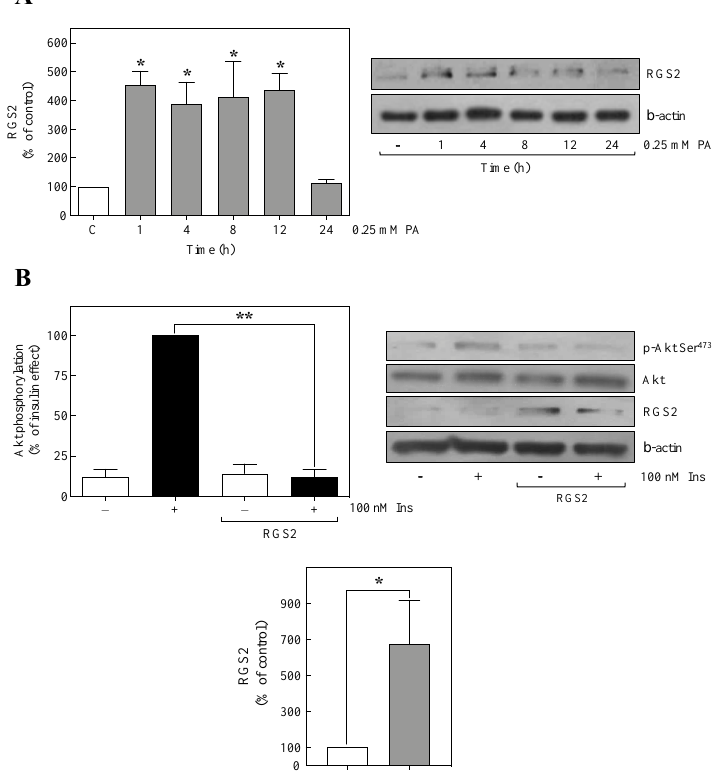
Figure 1. Increase in regulator of G-protein signaling 2 (RGS2) expression and insulin resistance. ( A ) Human umbilical vascular endothelial-CS (HUVEC-CS) cells were preincubated in the control medium (with dimethyl sulfoxide (DMSO)) for 24 h or medium containing 0.25 mM palmitic acid (PA) at different times before being harvested. Total cell lysates were separated by SDS-PAGE and analyzed by immunoblotting with anti-RGS2. Quantification of 3–6 independent experiments is expressed as mean ± S.E.M. The lower panel shows representative immunoblots. Western blots were also probed for total anti- β -actin as a loading control. ( B ) In the absence of PA, HUVEC-CS cells transiently transfected with human RGS2 were stimulated with 100 nM insulin for 10 min before being harvested. Total cell lysates were separated by SDS-PAGE and analyzed by immunoblotting with anti-p-Akt Ser 473 (upper graph). RGS2 expression levels from the experiments described above were quantified and plotted on a bar graph as the mean ± S.E.M. (bottom graph). The right panel next to the upper graph shows representative immunoblots. The data is representative of four independent experiments. Western blots were also probed for total Akt or β -actin. ( A , B ) * p < 0.05 vs. C. ( B ) ** p < 0.05 vs. Ins (+). C, control; Ins, insulin; PA, palmitic